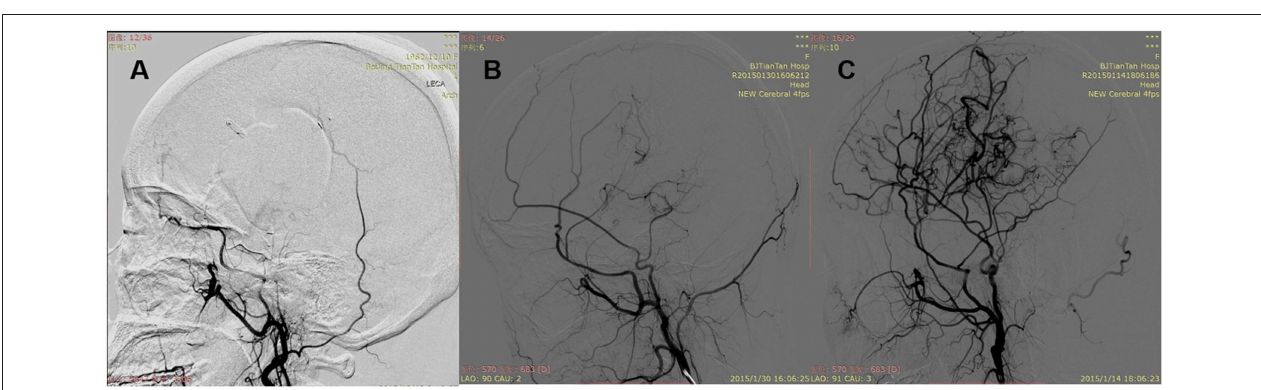
FIGURE 1 | (A) Normal: normal AChA. (B) Dilated: dilated AChA with distal branching or abnormal branches. (C) Negative: normal or dilated PComA. (D) Positive: dilated PComA with abnormal branch extensions.